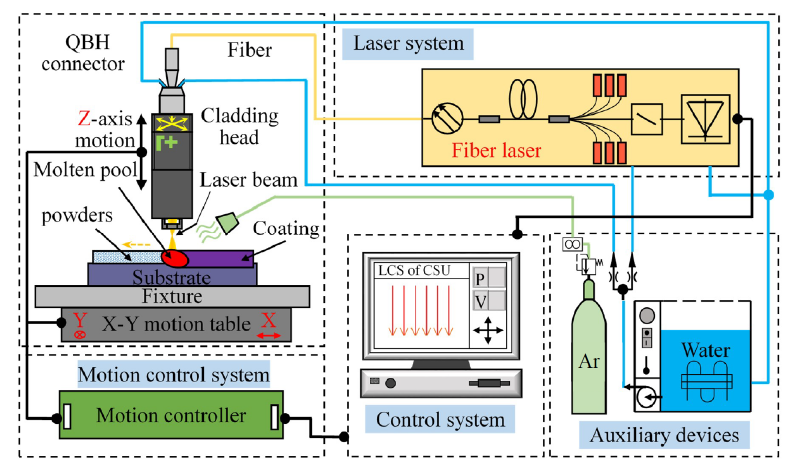
Figure 1. Schematic diagram of the laser cladding system. Table 3. The selected parameters for the laser cladding experiments.